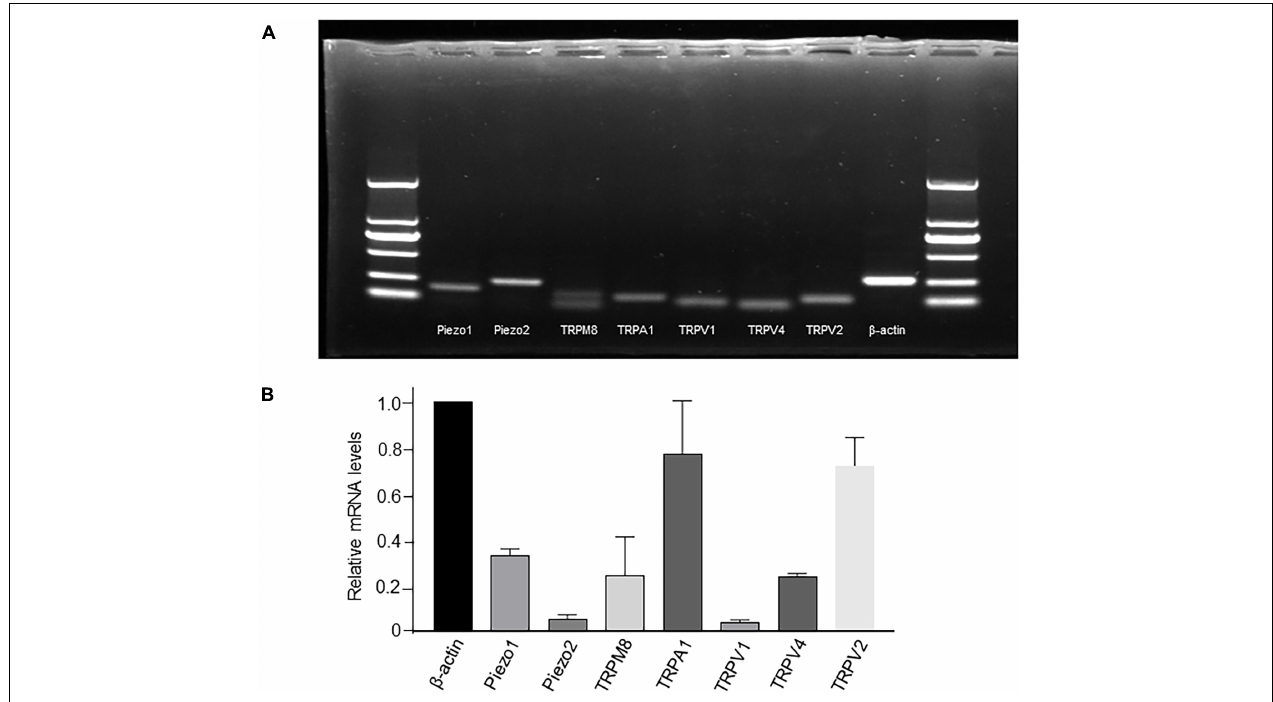
FIGURE 2 | mRNA expression of TRP and Piezo1/Piezo2 channels in cultured LP-ICs. Total RNA was extracted from cultured LP-ICs and RT-PCR (A) or RT-qPCR (B) was conducted. (A) Typical images demonstrating that Piezo1, Piezo2, TRPM8, TRPA1, TRPV1, TRPV4 and TRPV2 channels are expressed in LP-ICs. (B) Relative mRNA expression of TRP and Piezo channels to that of beta-actin. Relative mRNA expression of TRPA1 and TRPV2 are the highest, and that of Piezo1, TRPV4 and TRPM8 are moderate. Summary data are the average from five experiments.